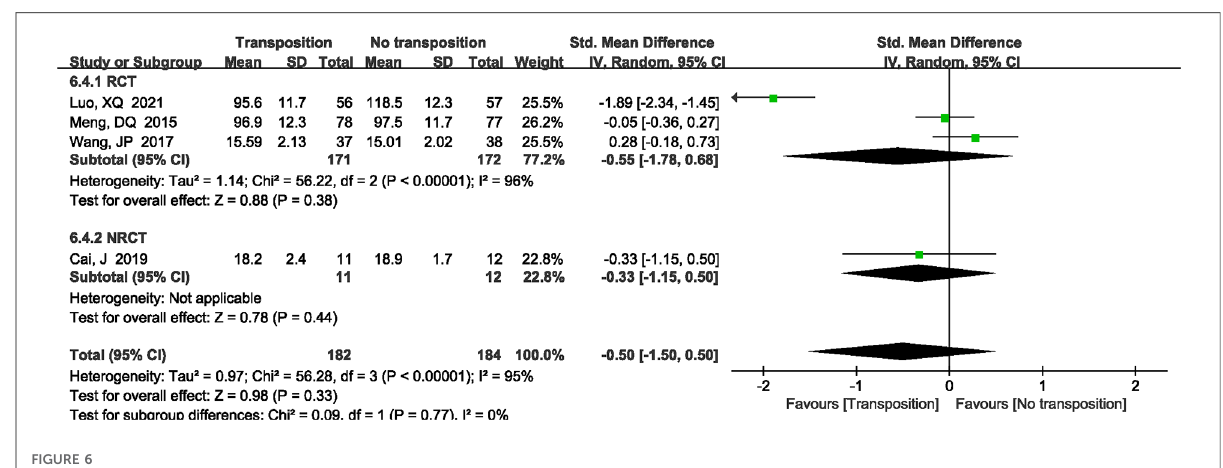
FIGURE 6 A forest plot showing the fracture healing